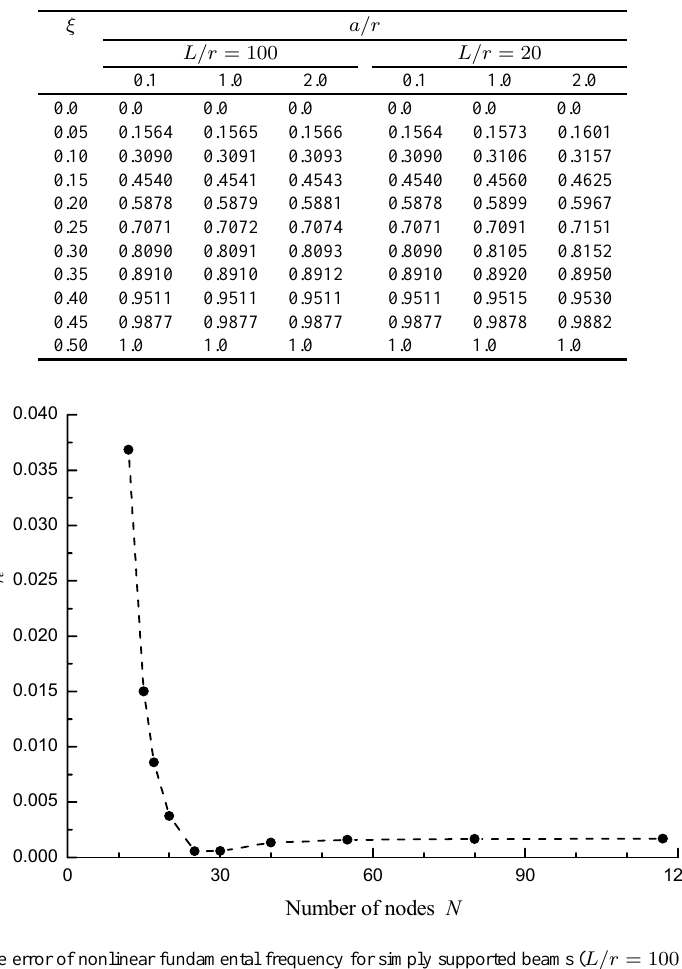
Fig. 2. Relative error of nonlinear fundamental frequency for simply supported beams ( L/r = 100 , a/r = 0 . 1 ). gyration even for simply supported beams. As a result, separation of space and time variables is inappropriate for nonlinear vibration analysis of stubby beams, but is applicable to the vibration analysis of simply supported slender beams with moderately large